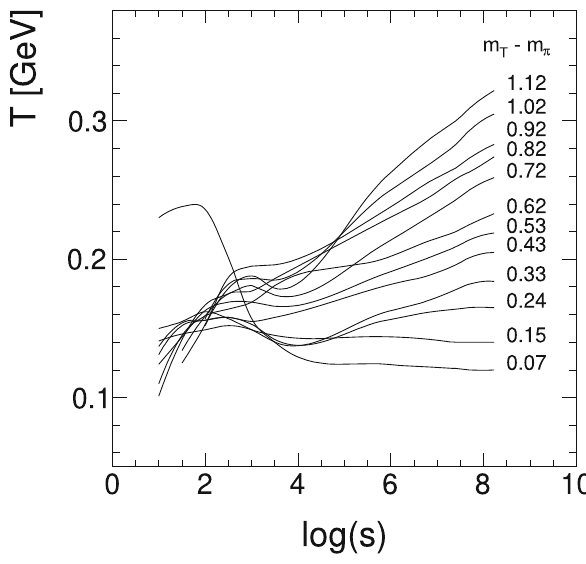
Fig. 142 Inverse slopes T for constant m T − m as a function of log ( s